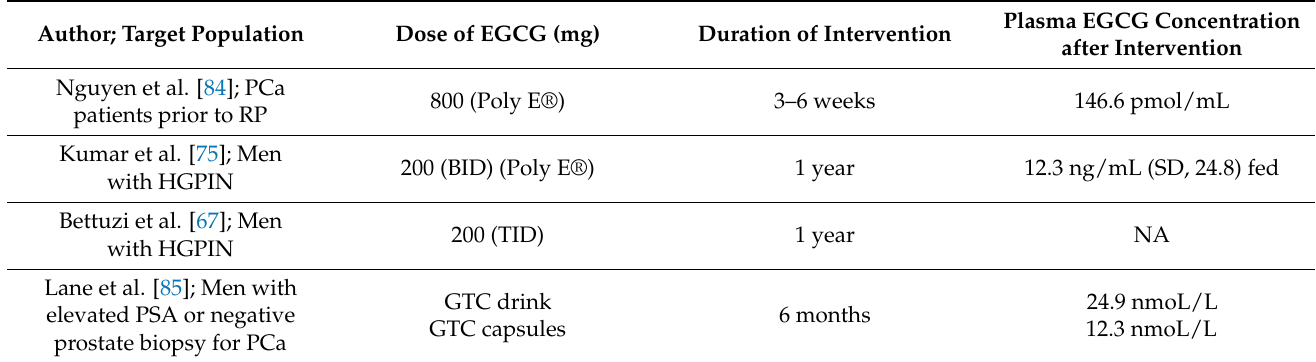
Table 1. Concentration of GTCs in plasma in interventional trials targeting men with